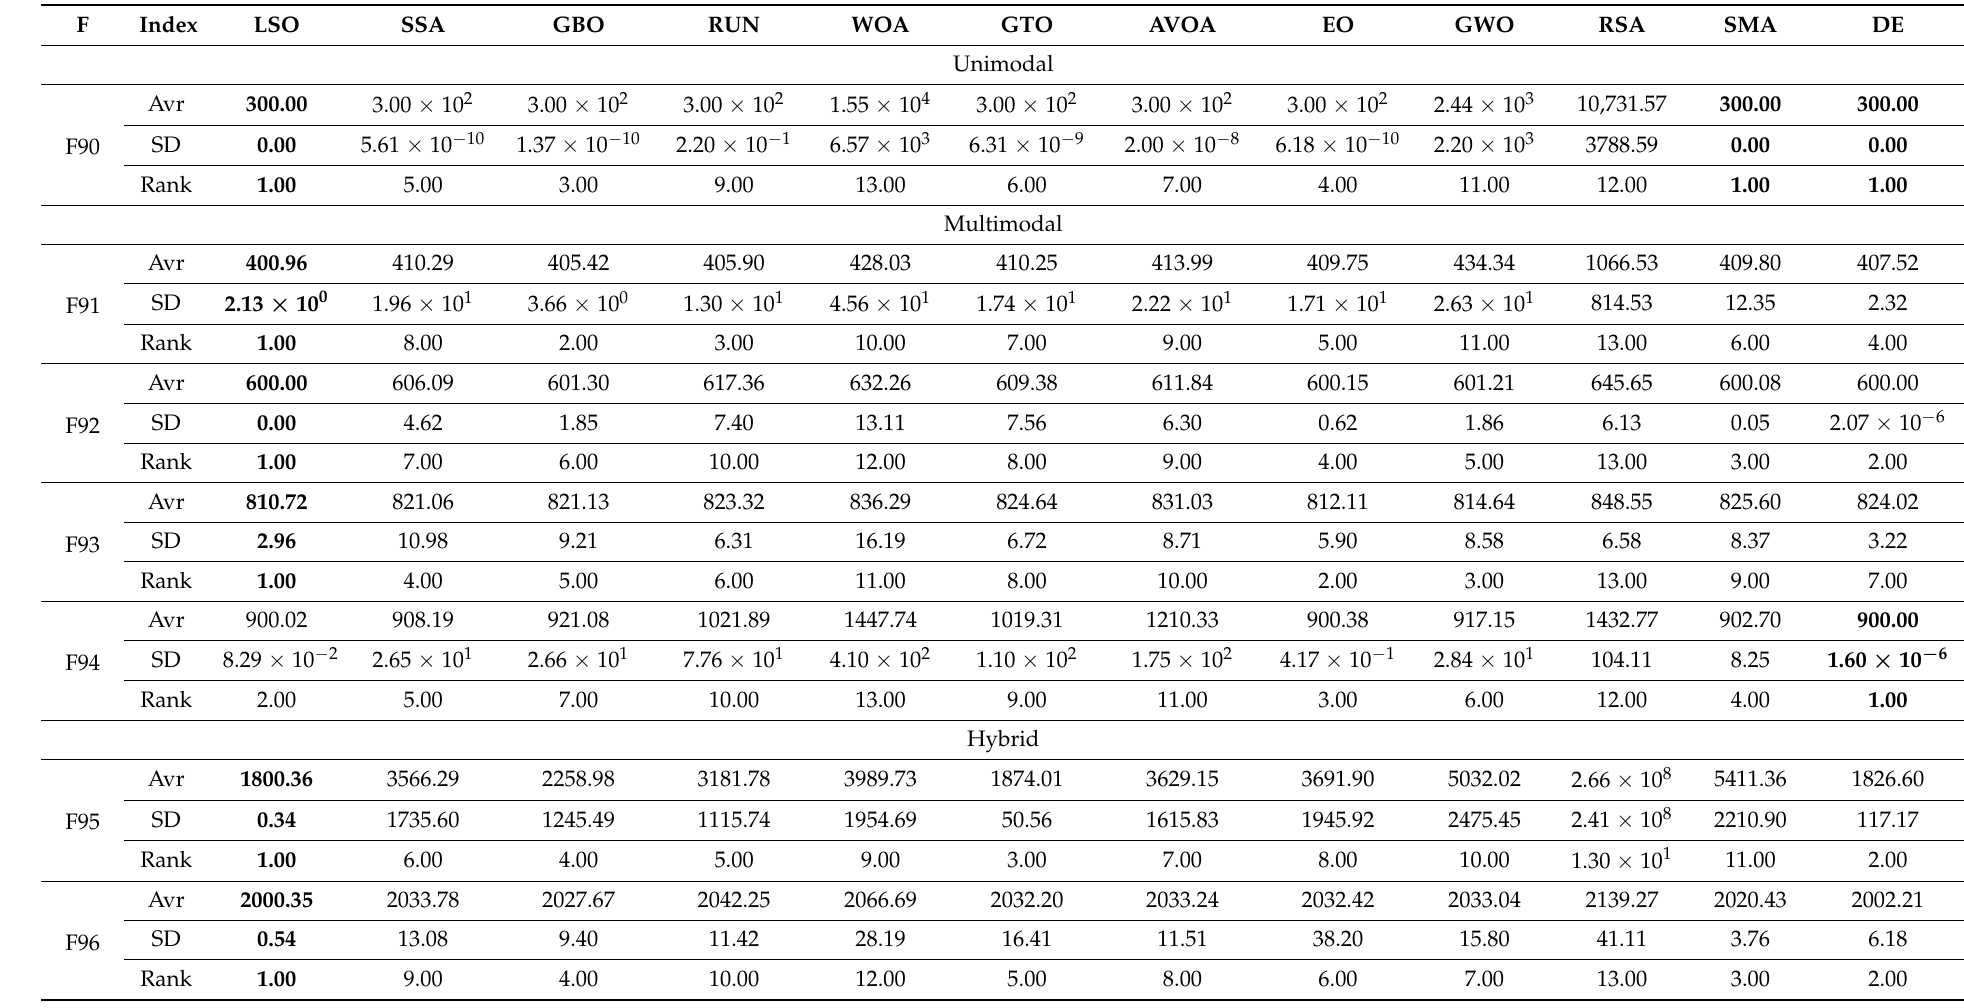
Table 14. Avr and SD of CEC2022 for 25 independent runs (The bolded value is the best